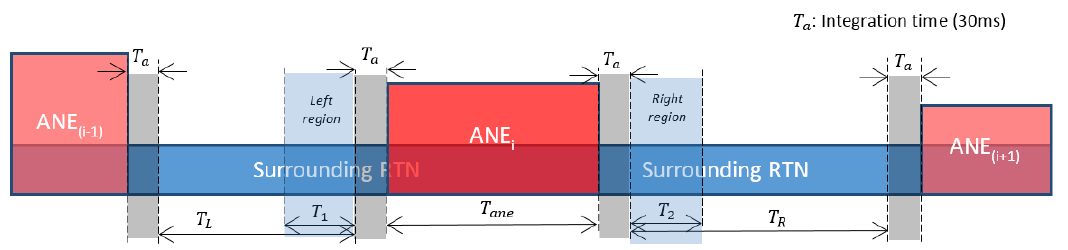
Figure 4. An anomalous noise event is surrounded by road traffic or background noise. In this case both regions of RTN are balanced.